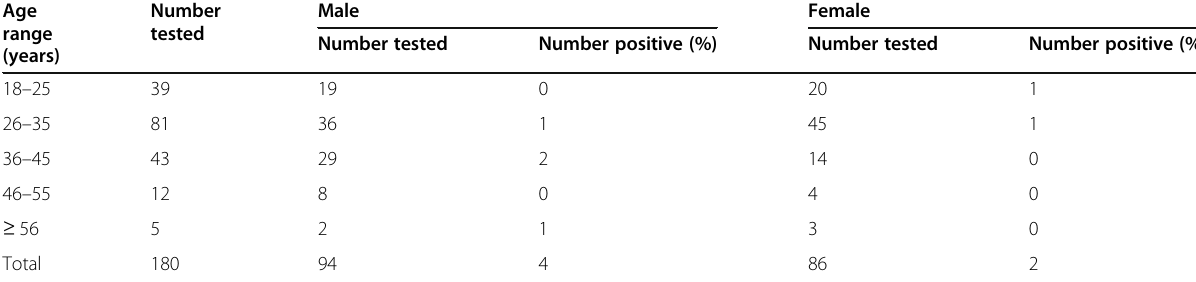
Table 1 Age and gender distribution of HDV infection among HBsAg-positive patients Age range